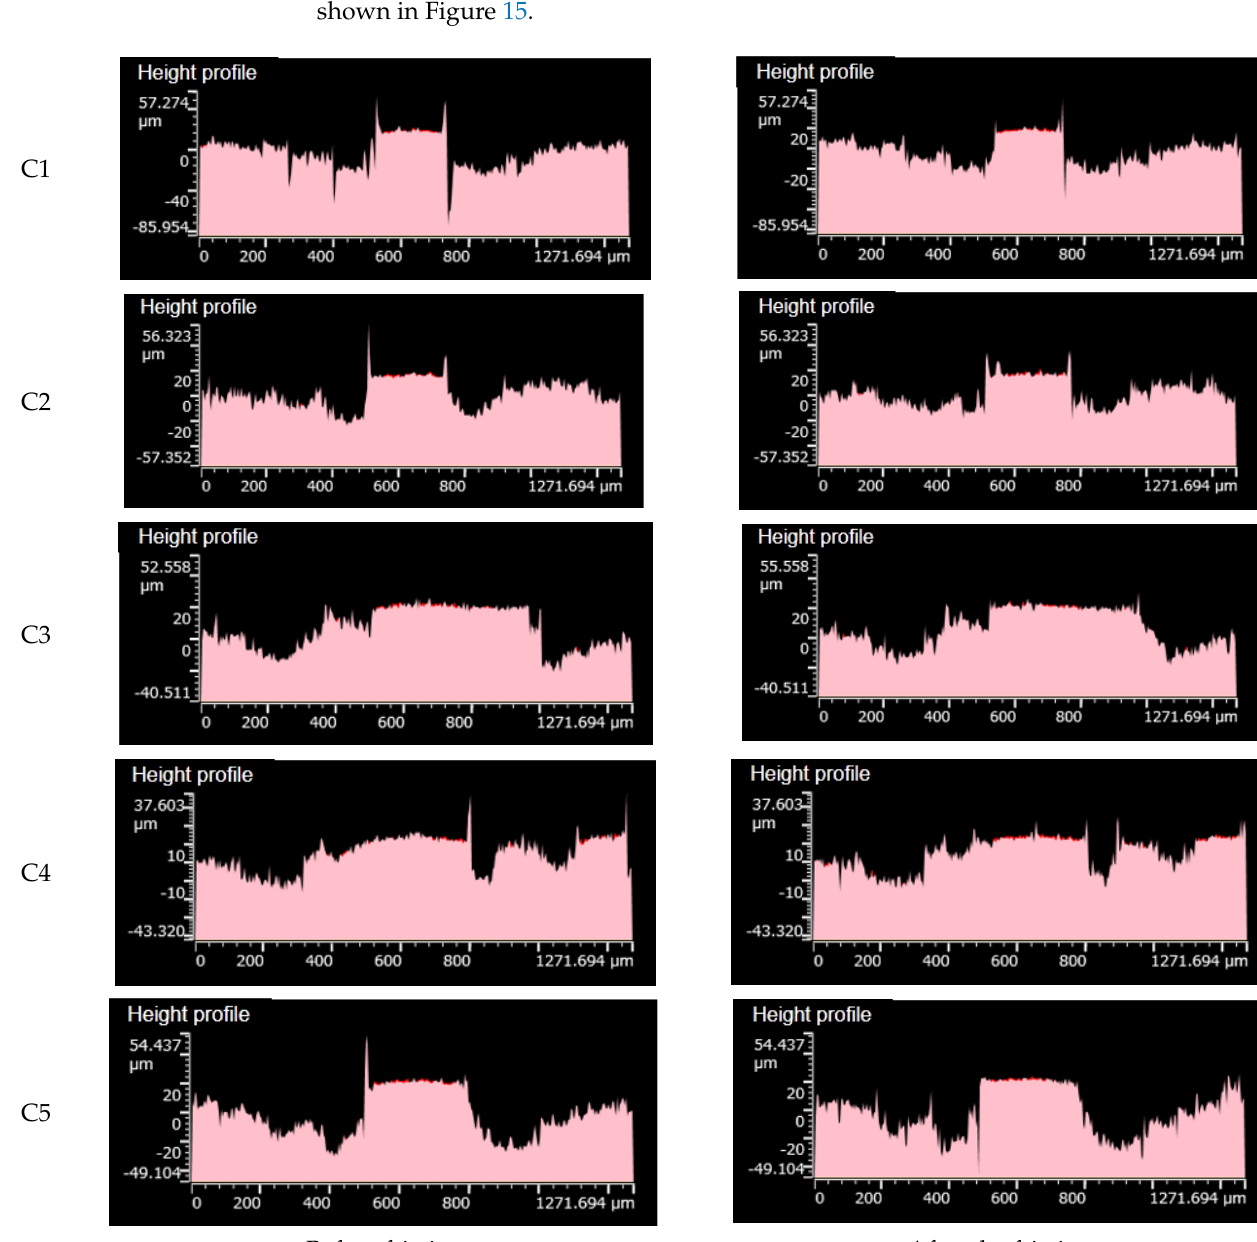
Before friction After the friction Figure 12. Height profiles before and after friction. Figure 12. Height profiles before and after